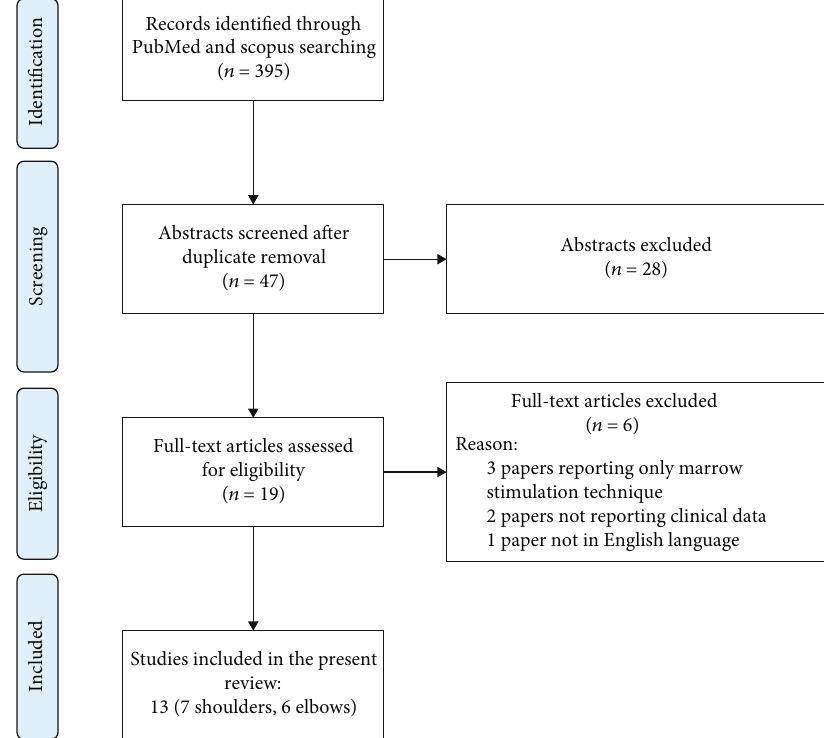
Figure 1: Flowchart resuming the paper ’ s selection process for the present